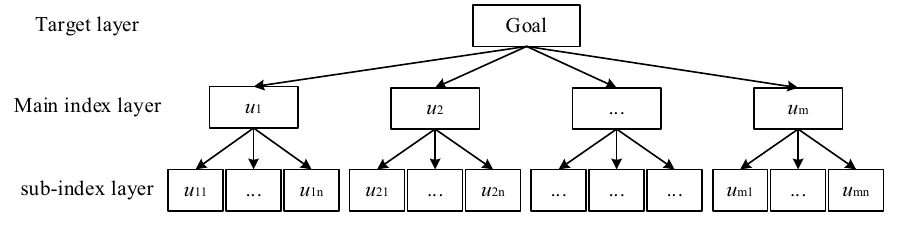
Figure 1. Hierarchical structure